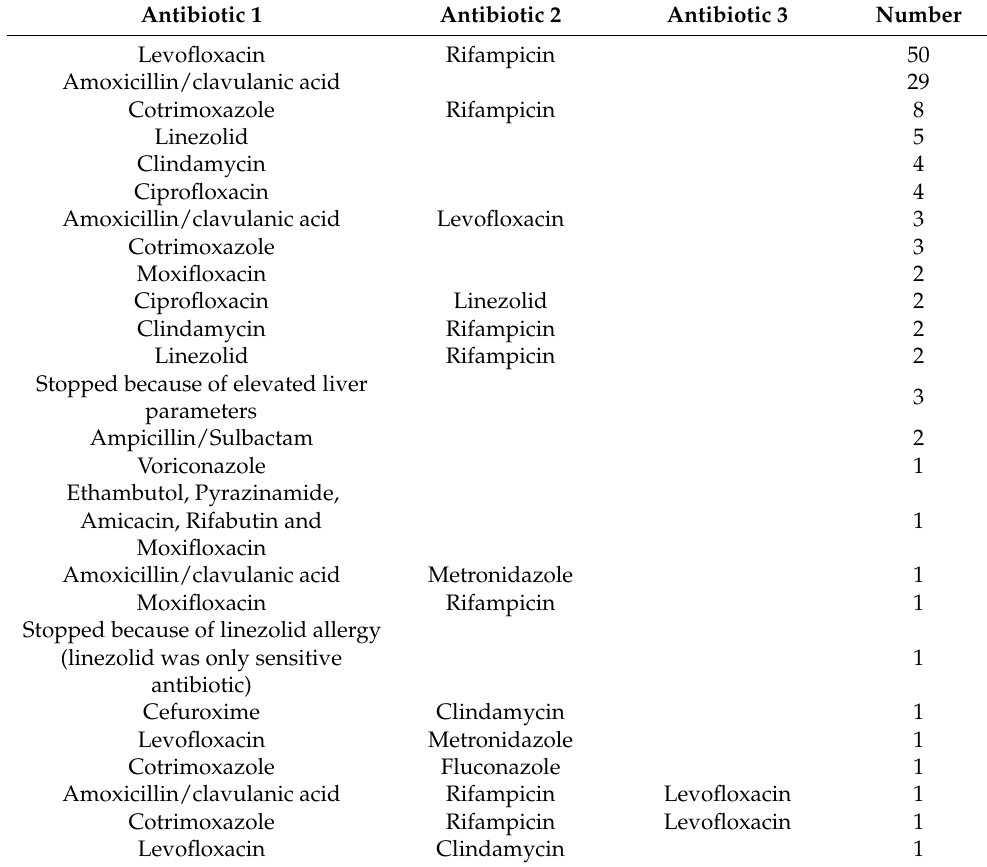
Table 5. Administered oral antibiotics or antimycotics or combination and number.